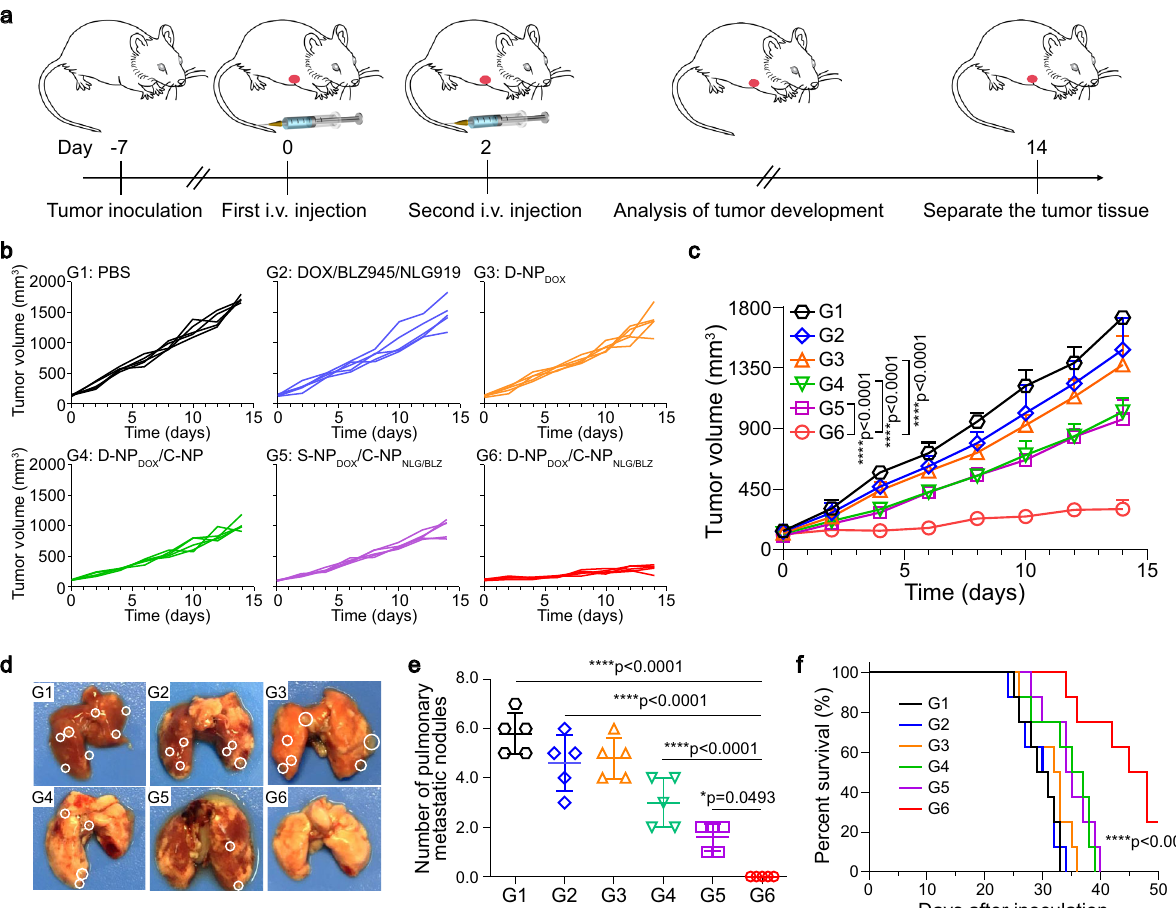
Fig. 6 Intratumoral in situ assembly of D-NP/C-NP to deliver multiple agents for ef fi cient cocktail chemoimmunotherapy. a Schematic illustrating the experimental protocol for cocktail chemoimmunotherapy in the 4T1 breast tumor model. b Individual and c average growth curves of 4T1 tumors ( n = 5). d Images of lung tissues collected from mice after various treatments. e The number of metastatic lung nodules of mice bearing 4T1 tumors at the end of treatment. Data are presented as the mean ± s.d. ( n = 5). Statistical signi fi cance was calculated via one-way ANOVA with a Tukey post hoc test in ( c , e ). * p < 0.05, **** p < 0.0001. f Survival rates of mice treated in different groups, n = 8 biologically independent animals. The statistical signi fi cance of the survival was calculated via log-rank (Mantel – Cox) test. **** p < 0.0001. i.v.: intravenously, PBS: phosphate-buffered saline. Source data are provided as a Source Data fi